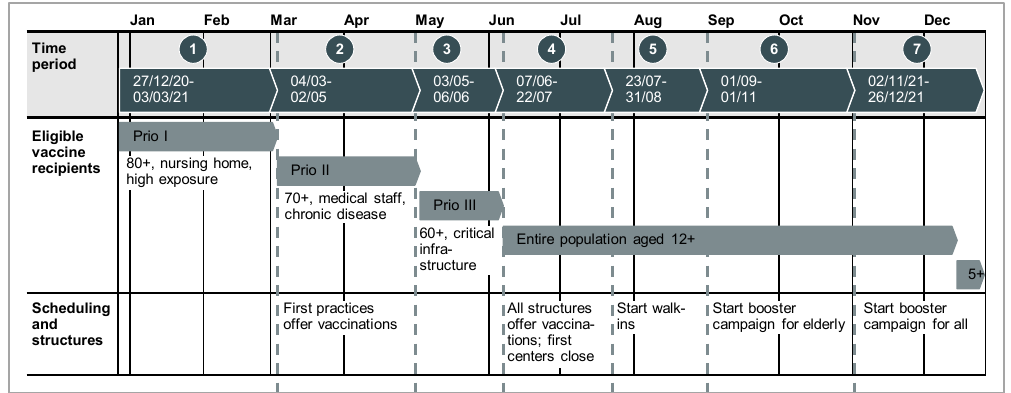
Figure 1. Overview of time periods for analysis from December 2020 to December 2021.